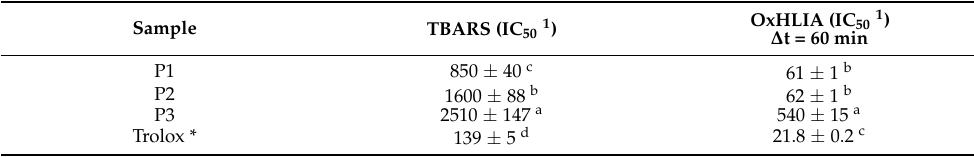
Table 13. Antioxidant activity at the optimal conditions for each extract ( µ g/mL).